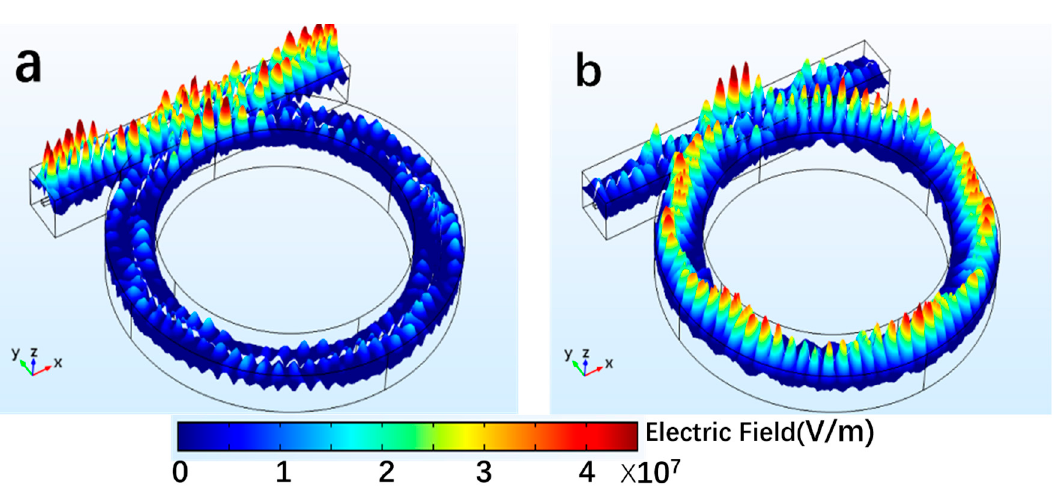
Figure 5. Distribution of the light field. The bias voltages are 5.4 V ( a ) and 6.6 V ( b ) respectively.